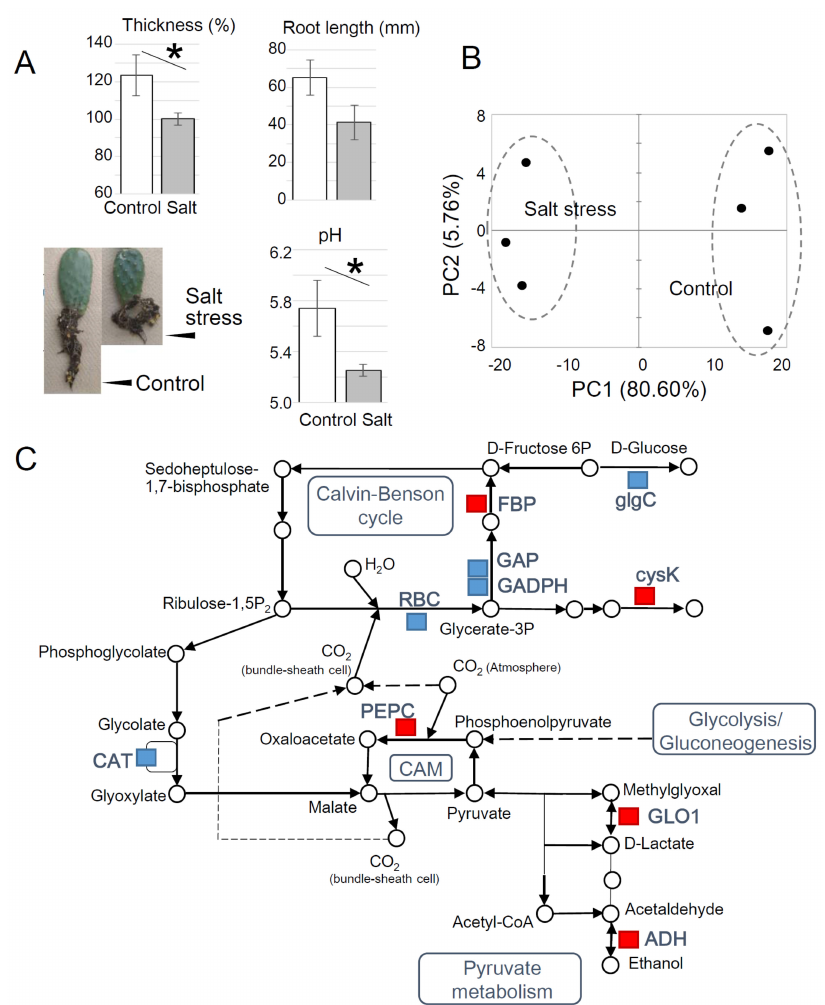
Figure 2. ( A ) Morphological changes of young O. ficus-indica plants grown from cladode cuttings after 11 days of salt stress treatment. Cladode thickness is expressed as the ratio to the value at the beginning of stress treatment. The pH of the hot water cladode tissue extracts was measured using a glass electrode pH meter. Each bar represents the mean ± S.D. ( n = 5 independent experiments) (* p < 0.05). ( B ) Principal component analysis of the change in plant protein profiles in response to salt stress. Each sample had three biological replicates. ( C ) Pathway mapping of the affected proteins. Proteins that increased or decreased in abundance with salt stress are shown in red and blue boxes,